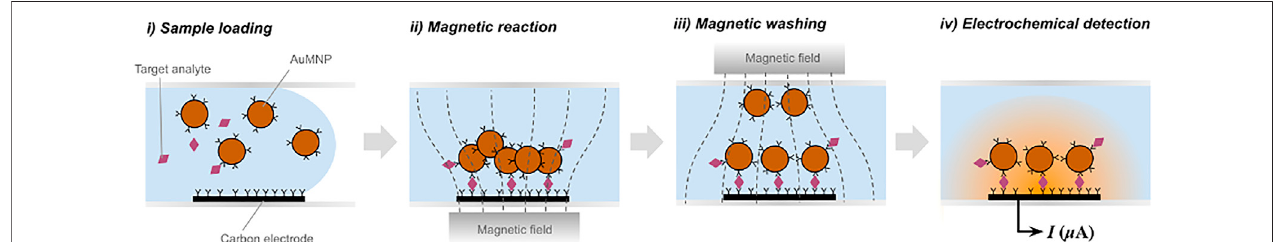
FIGURE 1 | Schematic diagram of magnetic force-assisted electrochemical sandwich immunoassays (MESIA).